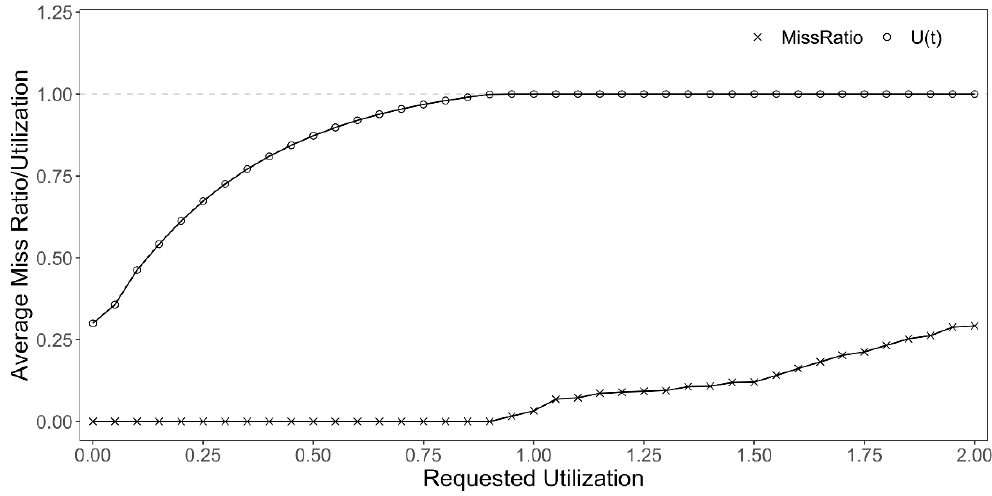
Figure 5. Total Utilization/Miss-Ratio with Step-Load (No QoS).